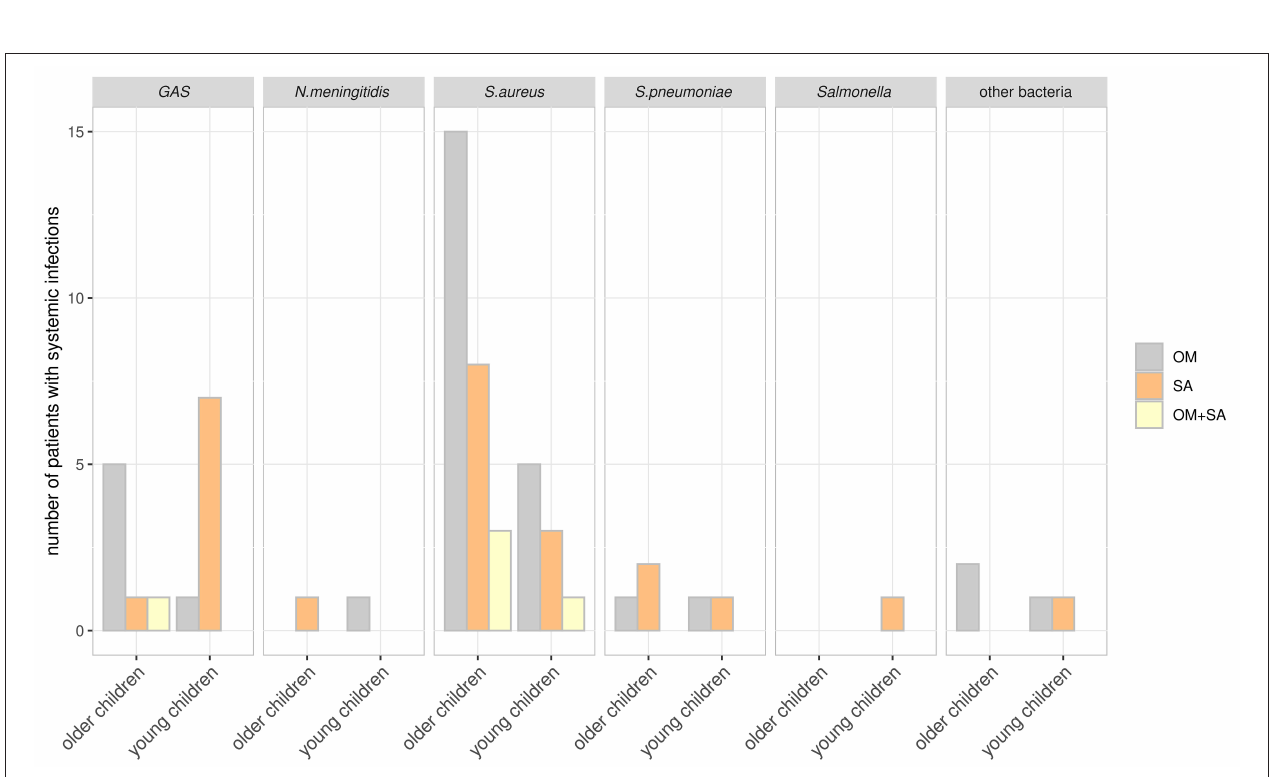
FIGURE 3 | Patients with systemic infections and pathogens detected. Patients were subgrouped according to age at hospital admission. Young children: > 3–60 months; older children > 60 months. Other bacteria: F. necrophorum , H. influenzae, S. milleri and M. tuberculosis .